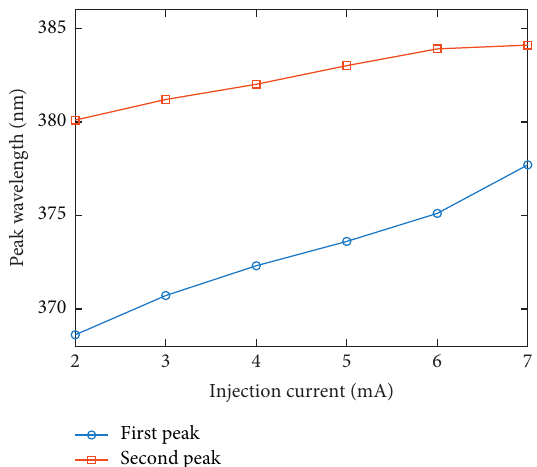
Figure 4: The relation between the positions of the first and second peaks and the injection